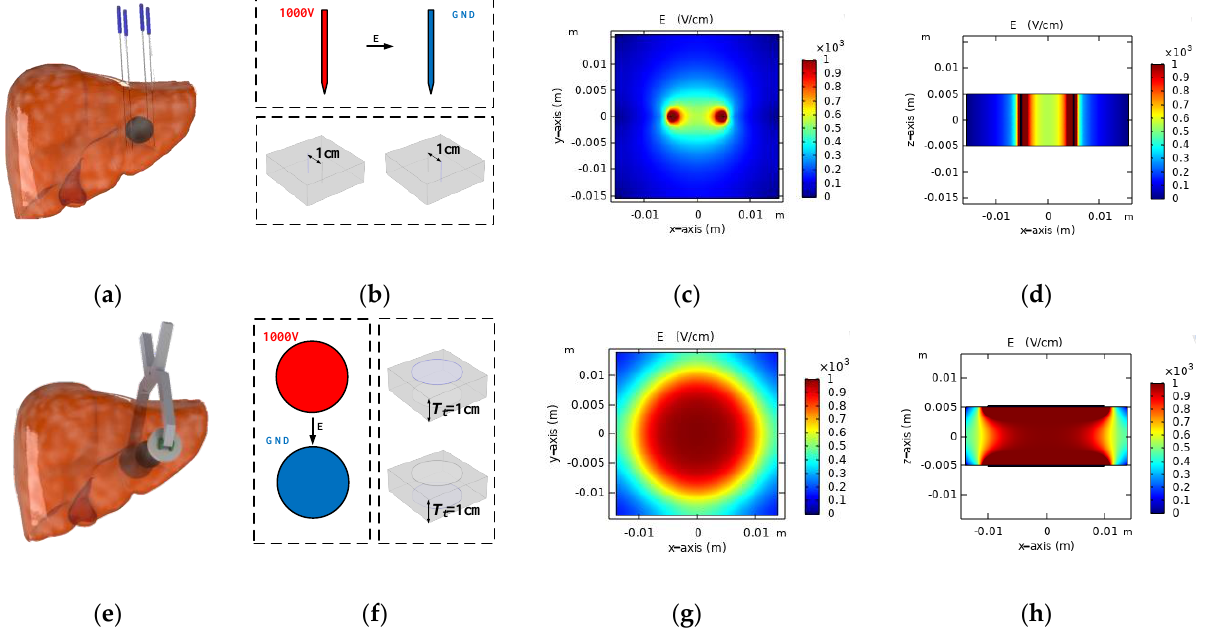
Figure 2. State-of-the-art electroporation electrodes applied to human liver tissue: Needle ( a ) and parallel-plate ( e ) electrodes. Finite element modeling of electroporation: Needle ( b ) and parallel-plate ( f ) electrodes. Electric field modulus in horizontal slice (z = 0): Needle ( c ) and parallel-plate ( g ) model. Electric field modulus in vertical slice (y = 0): Needle ( d ) and parallel-plate ( h ) model.